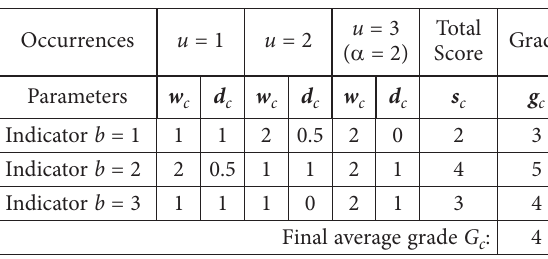
Table 4. Example of grading a competency throughout